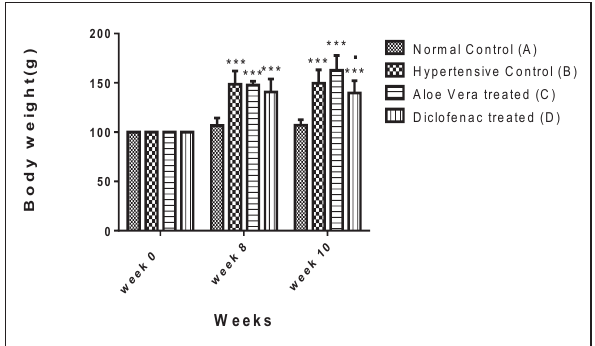
Fig-1: Effect of Aloe vera gel and diclofenac on body weight (mean±SD) of hypertensive rats (n=6) *** p value <0.001 Versus Group A Blood Pressure: